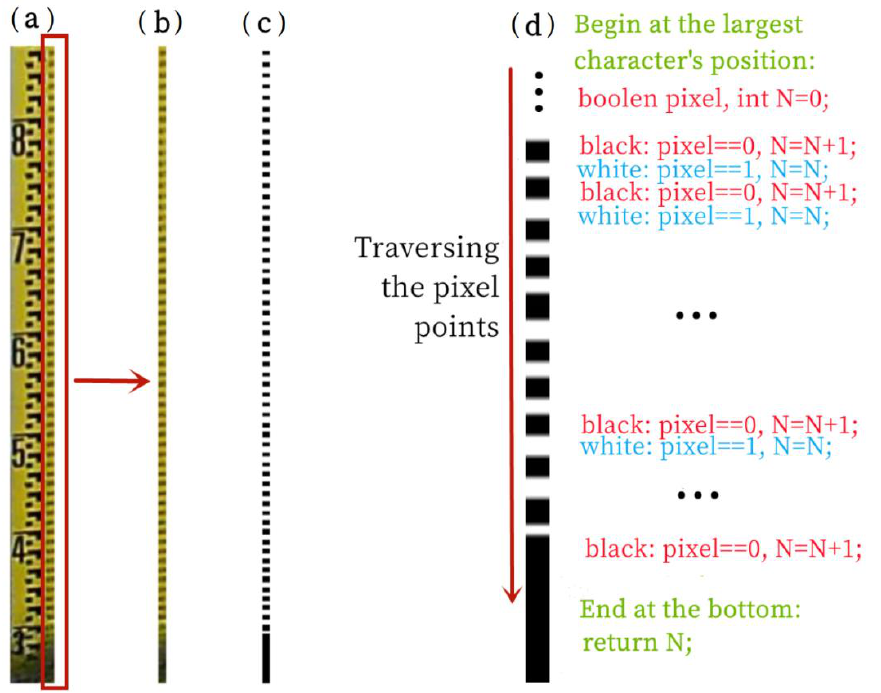
Figure 20. The accuracy ( left ) and loss ( right ) on training and validation.